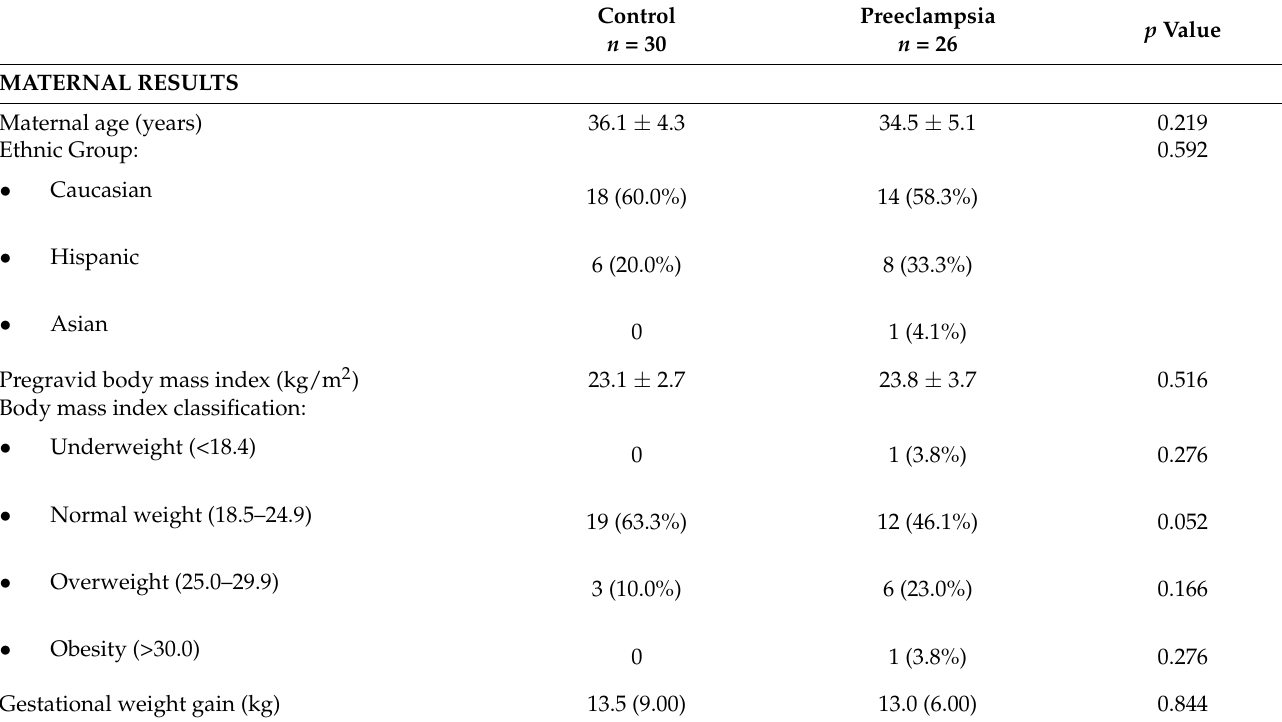
Table 1. Maternal, obstetric and perinatal